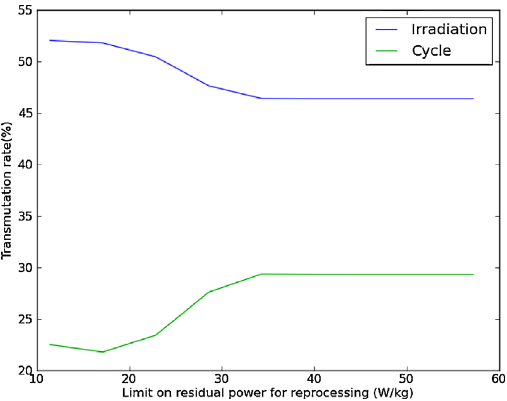
Fig. 6. Transmutation rate of 241 Am for irradiation and cycle versus limit on decay heat